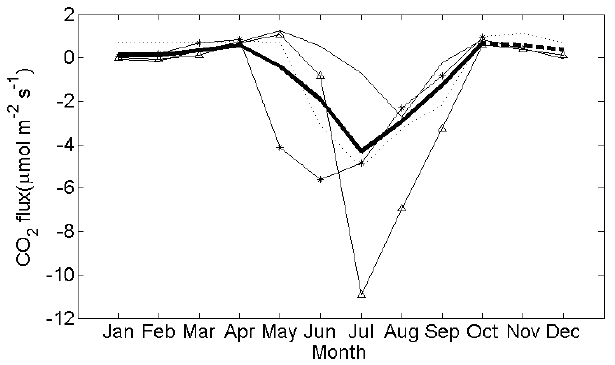
Figure 1. The biogenic CO 2 flux (thick solid line) from the land- scape around the tall tower, calculated from monthly averages of CO 2 flux from major land cover types. The fluxes for corn (solid line with triangles) and soybean (thin solid line) were measured with eddy covariance tower at the G21 and G19 sites near the tall tower in Minnesota. The fluxes for forest (dotted line) and grassland (solid line with stars) were from UMBS and USIB2 AmeriFlux sites in North America.